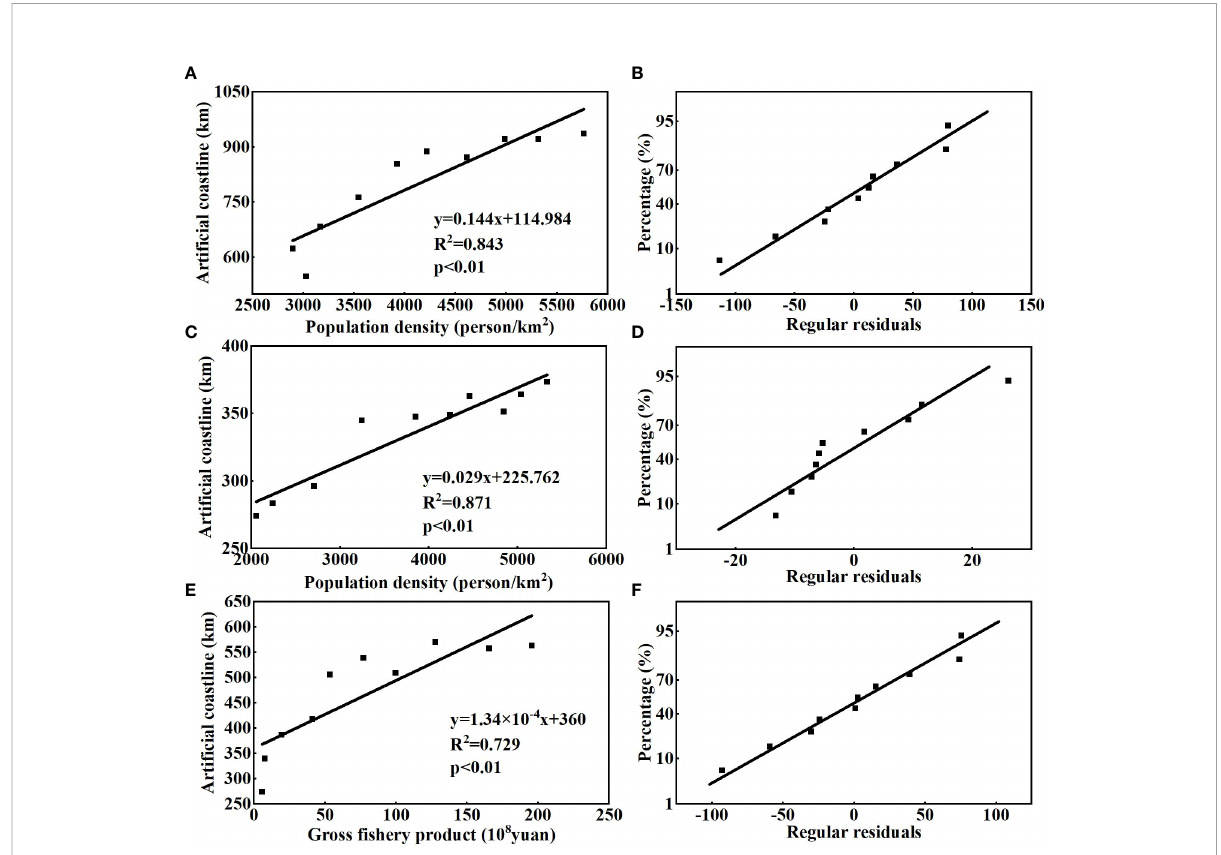
FIGURE 11 The relationship between arti fi cial coastline variations and dominant driving factors based on multivariate stepwise linear regression analysis: (A) the whole Pearl River Estuary (PRE), (C) East coast in the PRE, (E) West coast in the PRE; and the residual plots for regression analysis: (B) the whole Pearl River Estuary (PRE), (D) East coast in the PRE, (F) West coast in the PRE (R 2 represents determination coef fi cient and p represents signi fi cance